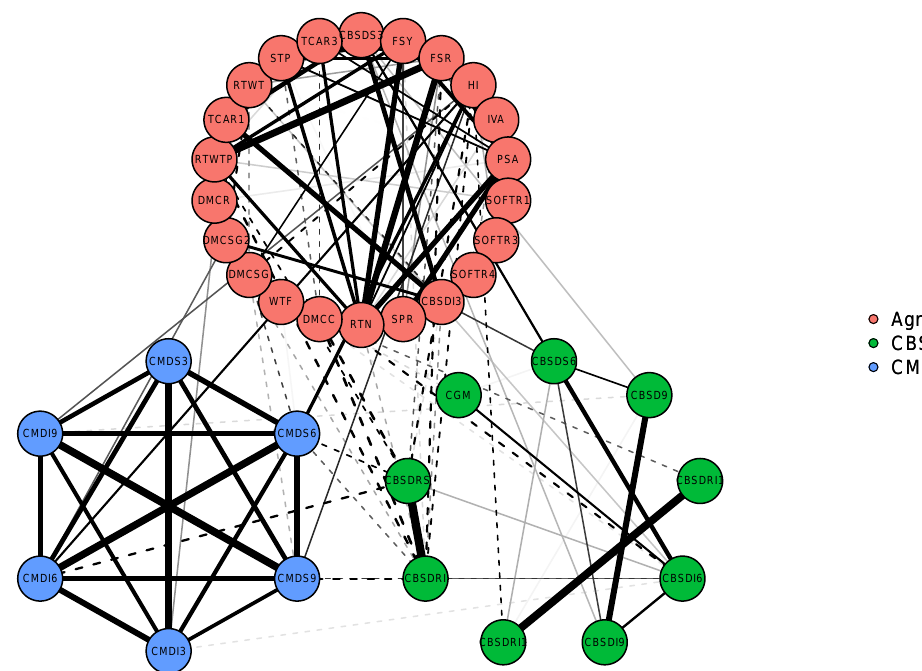
Figure 6. Illustration 4—Cassava data: A covariance graph for the covariance matrix resulting in a combined covariance matrix for 37 traits obtained by combining the sample covariance matrices from 50 phenotypic trials downloaded from CassavaBase. The green colored lines represent positive trait correlations, red colored lines represent negative trait correlations. The thickness of the line is an indication of the strength of the correlation. The traits that are not connected with any lines are estimated to be marginally independent. The abbreviations for the traits are the same as those given in Figure 5. Similar traits are grouped and have the same color